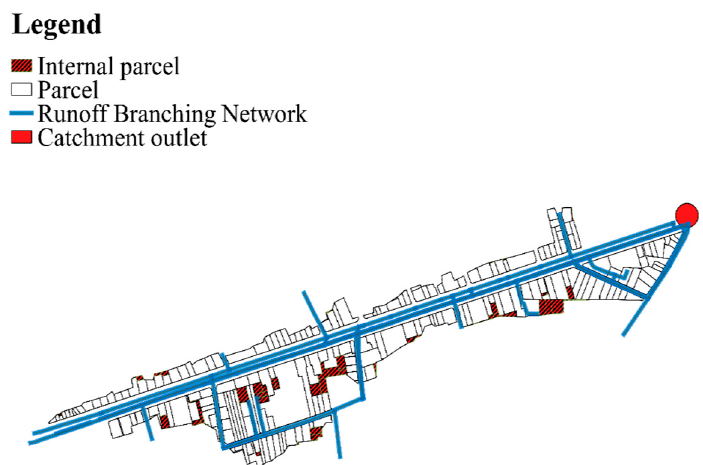
Figure 2. Cadastral parcels of the Le Perreux catchment. White parcels represent the UHEs, including a fraction of the adjacent street. Red dashed parcels represent isolated UHEs. The blue lines and the red circle represent the segments of the hydrological network and the catchment outlet respectively.